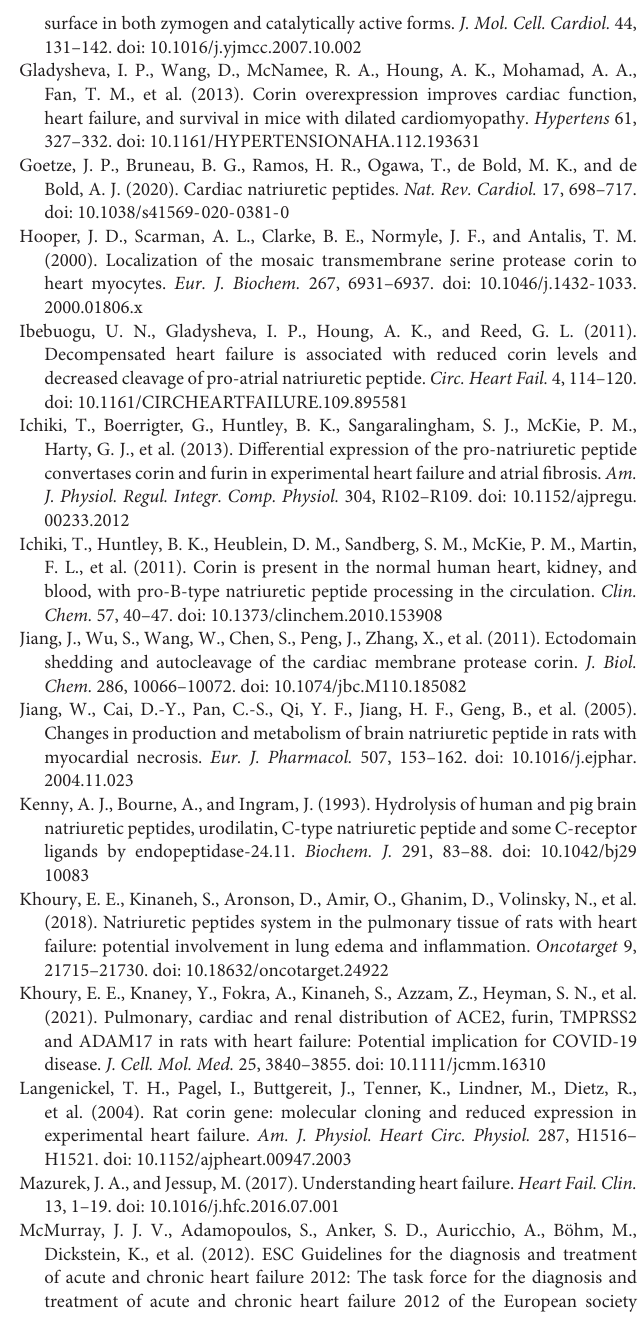
Supplementary Table S1 | Impact of aortocaval placement on heart, lung, and kidney weights as compared with sham operated controls. Cardiac, lung, and kidney weights expressed either as absolute values or relative to bodyweight of rats with compensated and decompensated CHF and their sham controls. Values are means ± SEM. ∗ P < 0.05; ∗∗ P < 0.01; ∗∗∗ P < 0.001; ∗∗∗∗ P < 0.0001